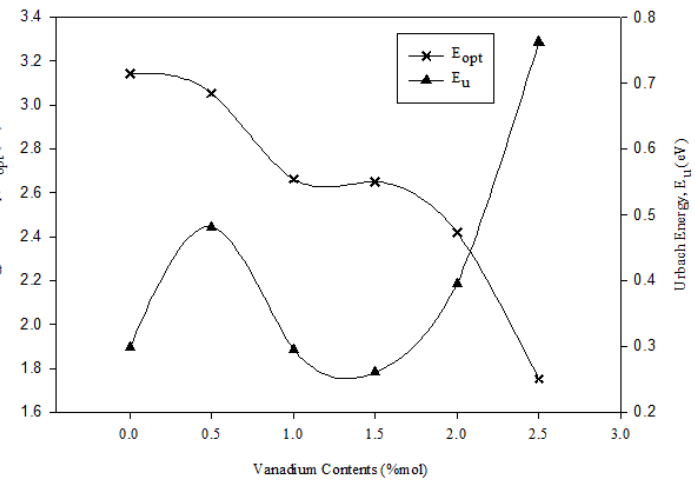
Figure 9. Optical band gap (E opt ) and Urbach energy of (59.5– x ) B 2 O 3 –20Na 2 O–20CaO – x V 2 O 5 –Er 2 O 3 –0.5AgCl ( x = 0, 0.5, 1.0, 1.5, 2.0 and 2.5 mol%).